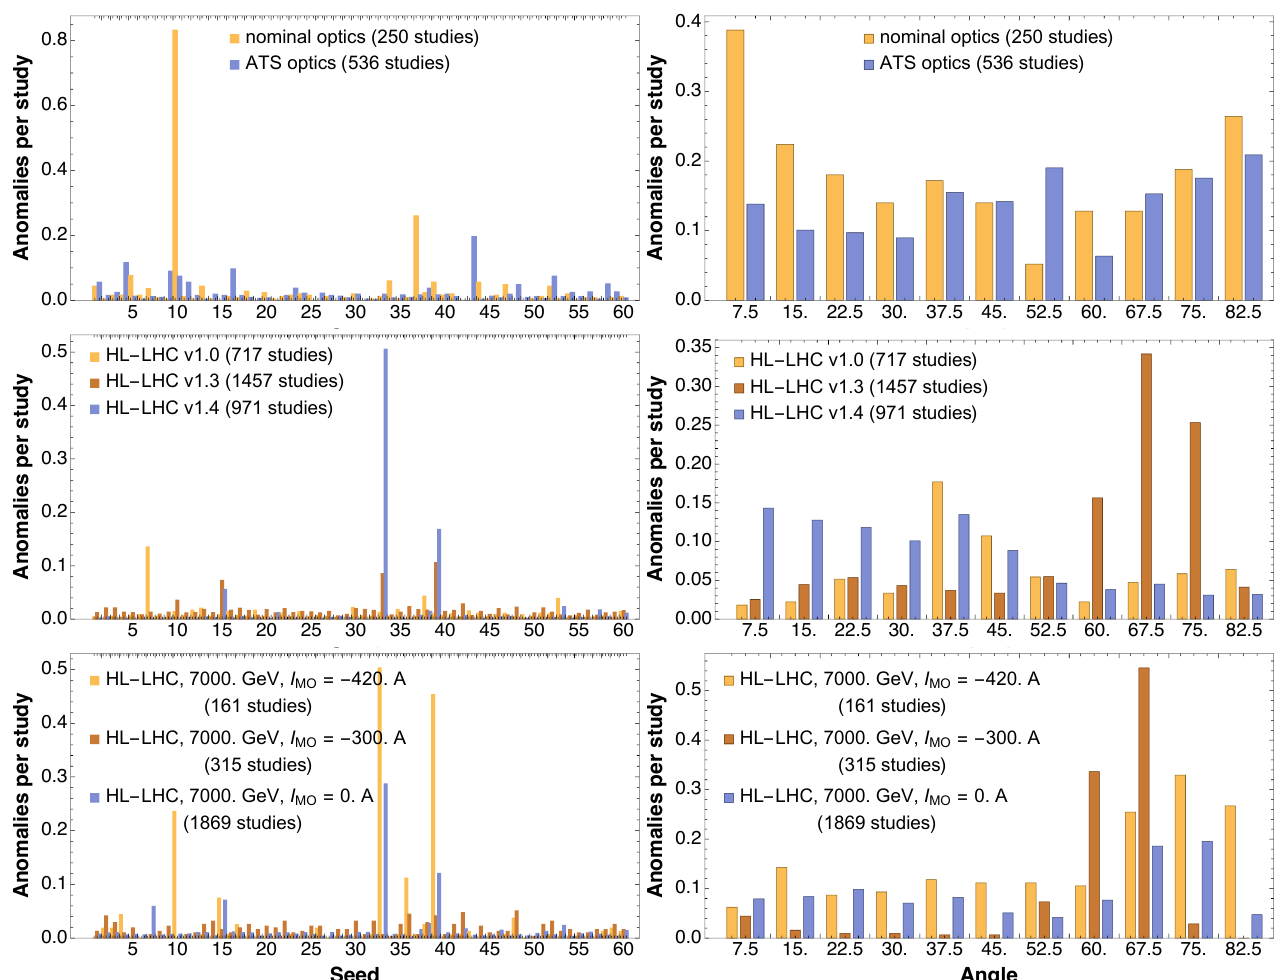
Figure 7. Distribution of outliers as a function of seed ( left ) and angle ( right ) for various configurations used in the numerical simulations performed to compute the